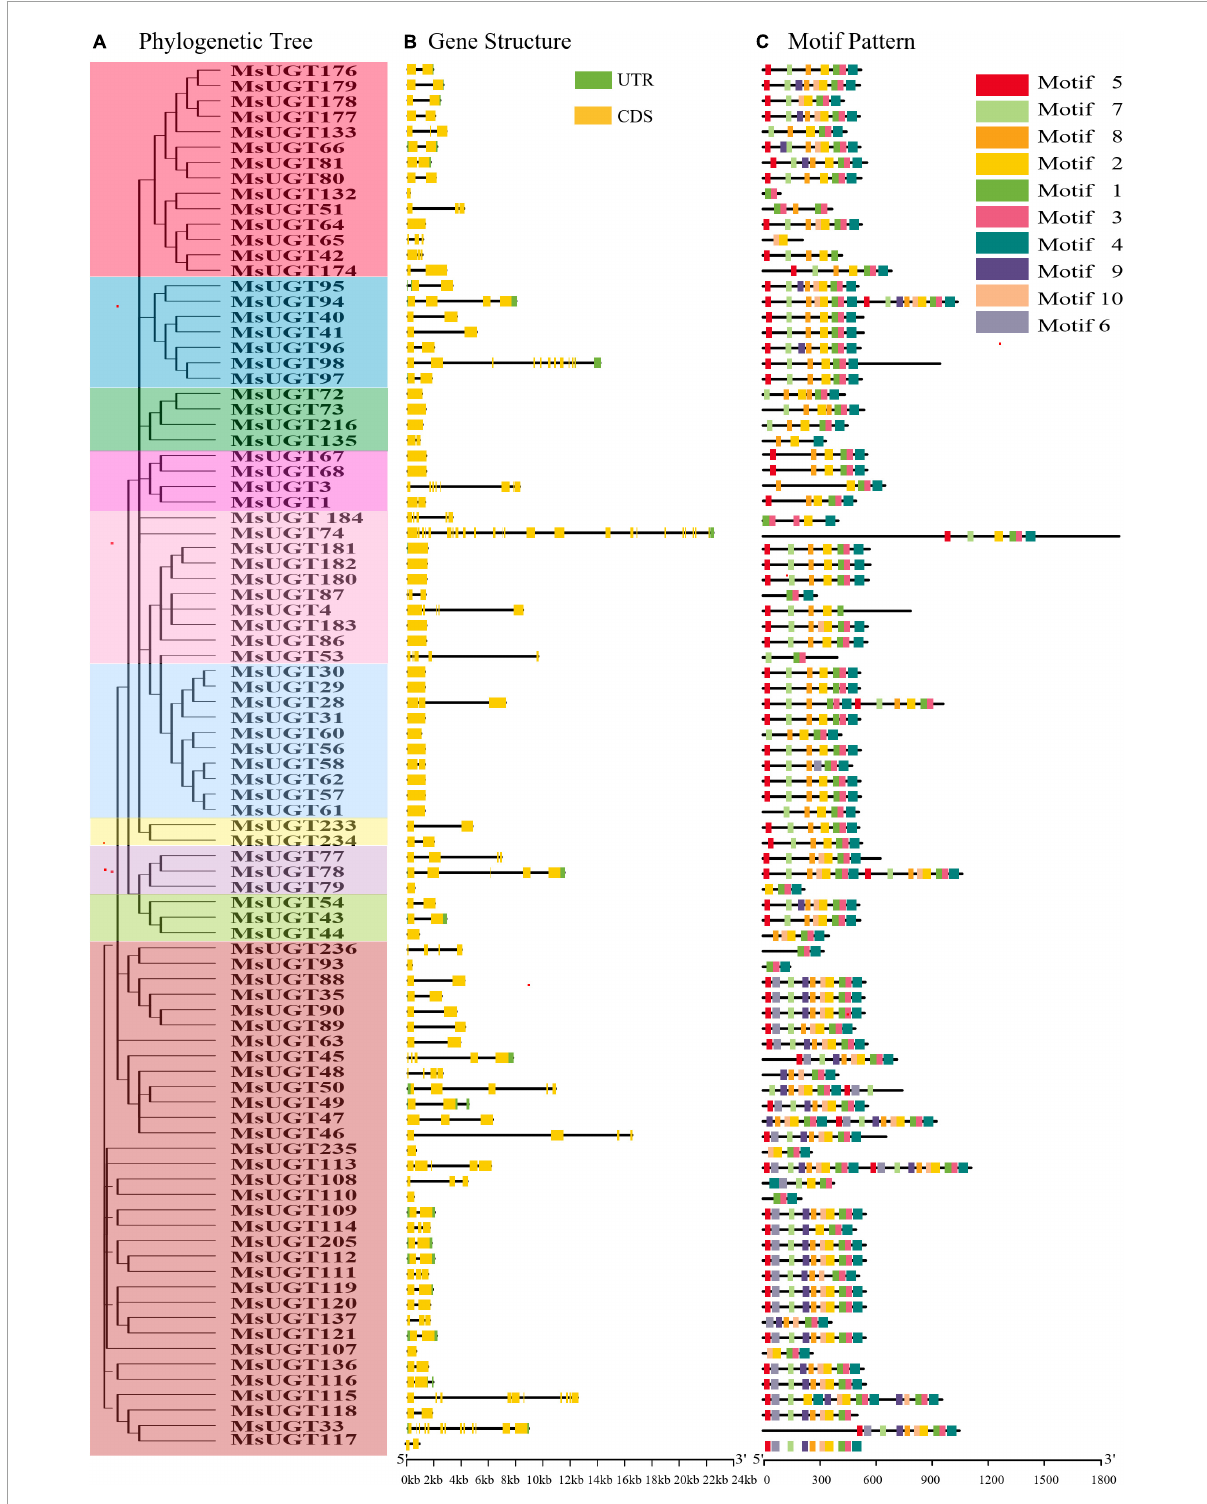
FIGURE4 The phylogenetic relationship, exon-intron structure, and conservative motif analysis of 90 UGT genes associated with secondary metabolism in alfalfa. (A) The phylogenetic tree of 90 MsUGTs was constructed by the NJ method with 1,000 repeats. (B) The exon-intron structure analysis of 90 UGT genes was represented in detail. (C) The conservative motif analysis of 90 MsUGTs was predicted. Each phylogenetic group is indicated by the same color used in the evolutionary tree in Figure 2A